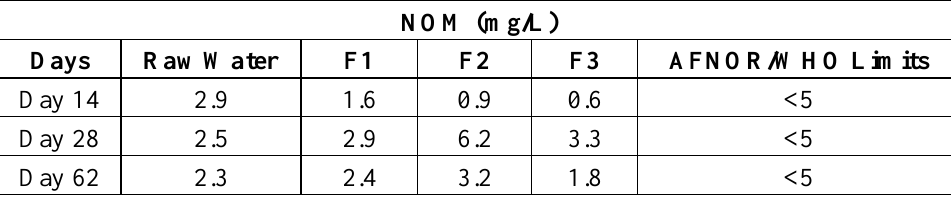
Table 5. Natural organic matter levels as measured by permanganate